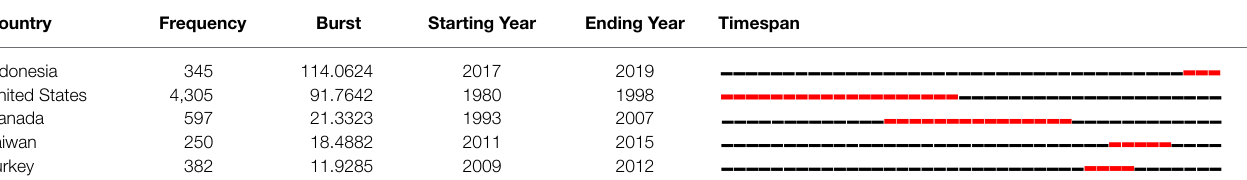
TABLE 5 | Top 5 country-level bursts in the intellectual structure of scientific literacy between the years 1980 to 2019. Country